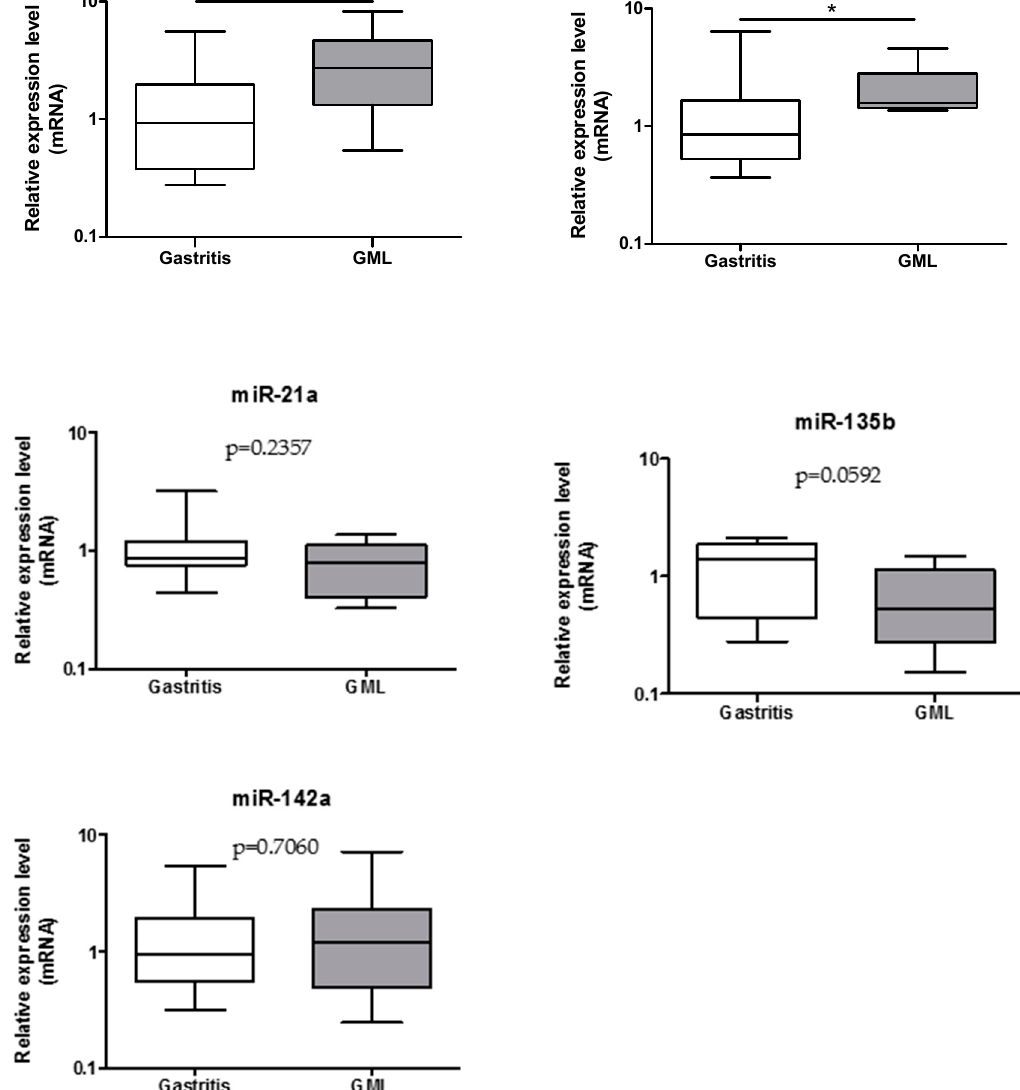
Figure 1. Relative expression levels of miR-155, miR-150, miR-21a, miR-135b, and miR-142a in gastritis and gastric mucosa-associated lymphoid tissue (MALT) lymphomas patient stomachs. Expression levels quantified by RT-qPCR for the gastric MALT lymphomas ( n = 11) human group was normalized in comparison to expression levels for the gastritis ( n = 17) control group. RNU6, RNU5A, and SNORD95 were used to normalize miRNA expression levels. Data are plotted as box plots, with the box representing 50% of values around the median (horizontal line) and the whiskers representing the minimum and maximum of all the data. * p < 0.05.